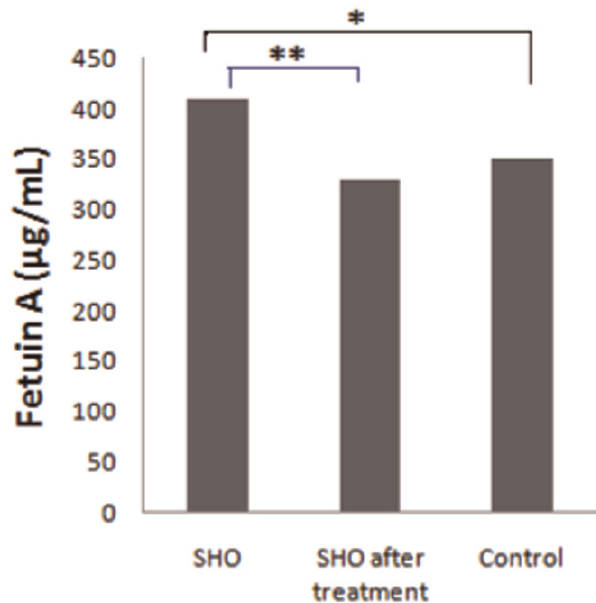
Figure 2 - Comparisons of fetuin A level in SHO group, SHO patients after treatment and healthy controls. (* p =0.019)